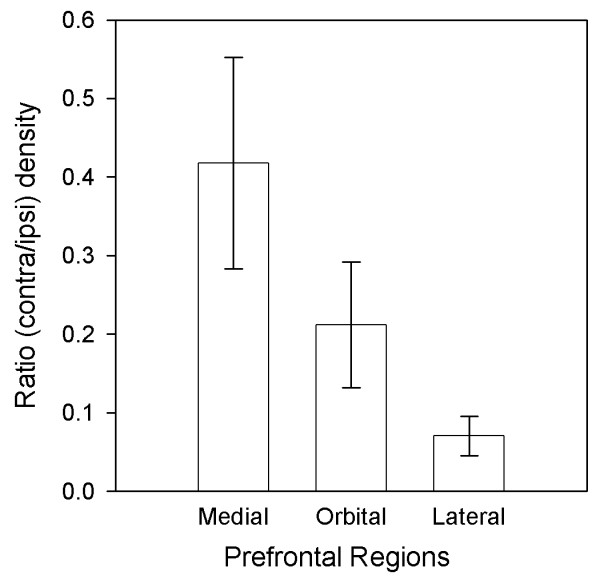
Regional average for ratios of contralateral to ipsilateral projection densities. The apparent trend of progressively smaller contralateral projection densities in medial prefrontal, orbital and lateral prefrontal cortices was significant (rank correlation ρ, p < 0.01).